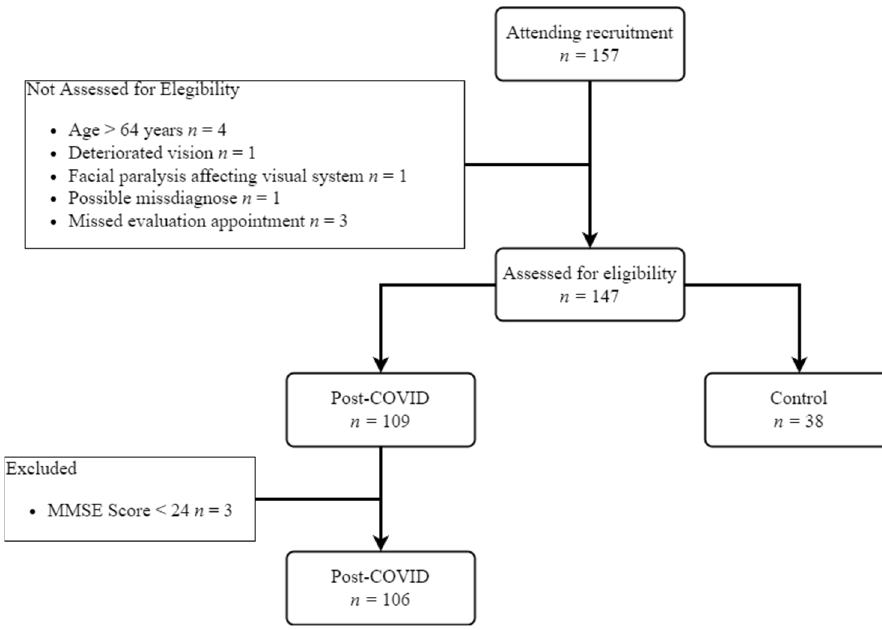
Figure 4. Recruitment and eligibility flowchart. Table 1. Descriptive variables of the